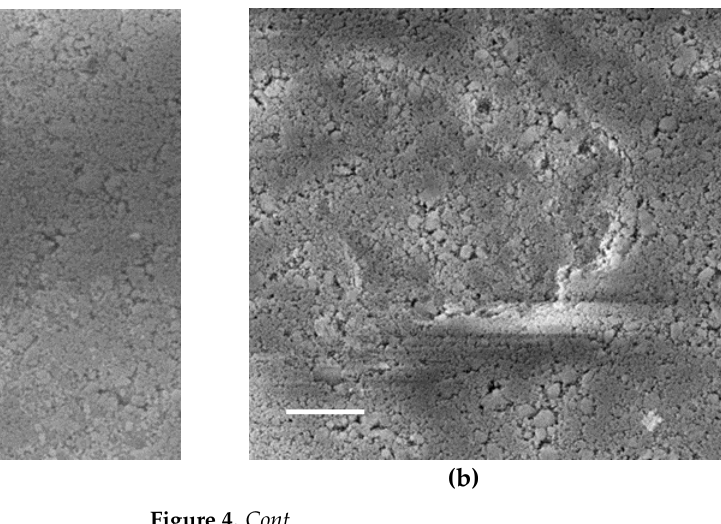
Figure 2. Young’s modulus as measured by CSM versus penetration depth with a 2000-µm diameter sphere for FS (in green) and PS (in blue) compacts .